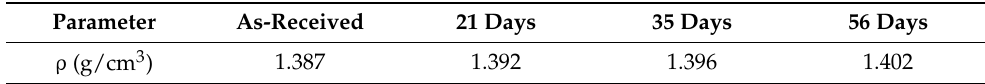
Table 1. PET density measured by the hydrostatic method.